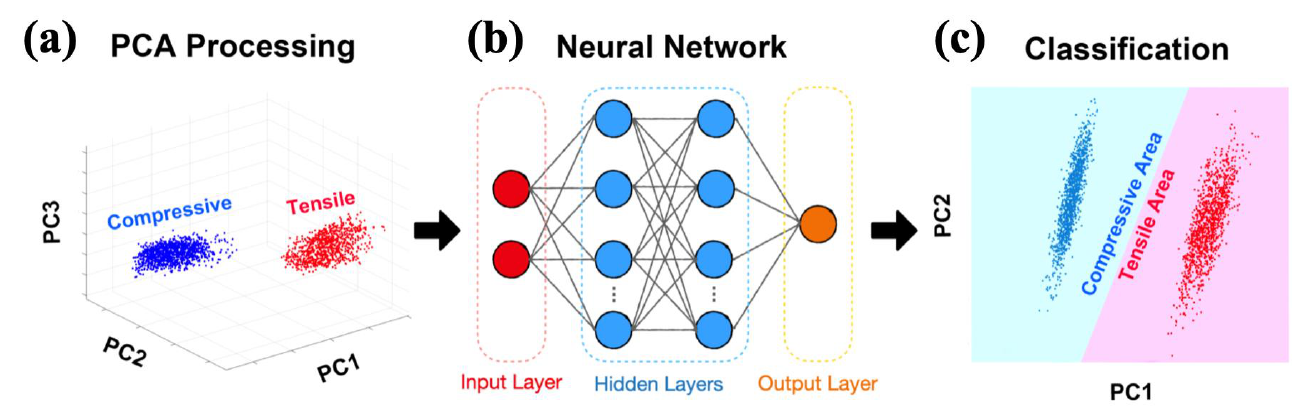
Figure 3. ( a ) After calculating film stress from XRD, we used PCA to help group the data according to compressive and tensile stress, and here shows a subset of the data plotted with respect to the first three principal components from PCA; ( b ) Diagram of MLP—a feed-forward artificial neural network; ( c ) Model based on the neural network to complete the classification.